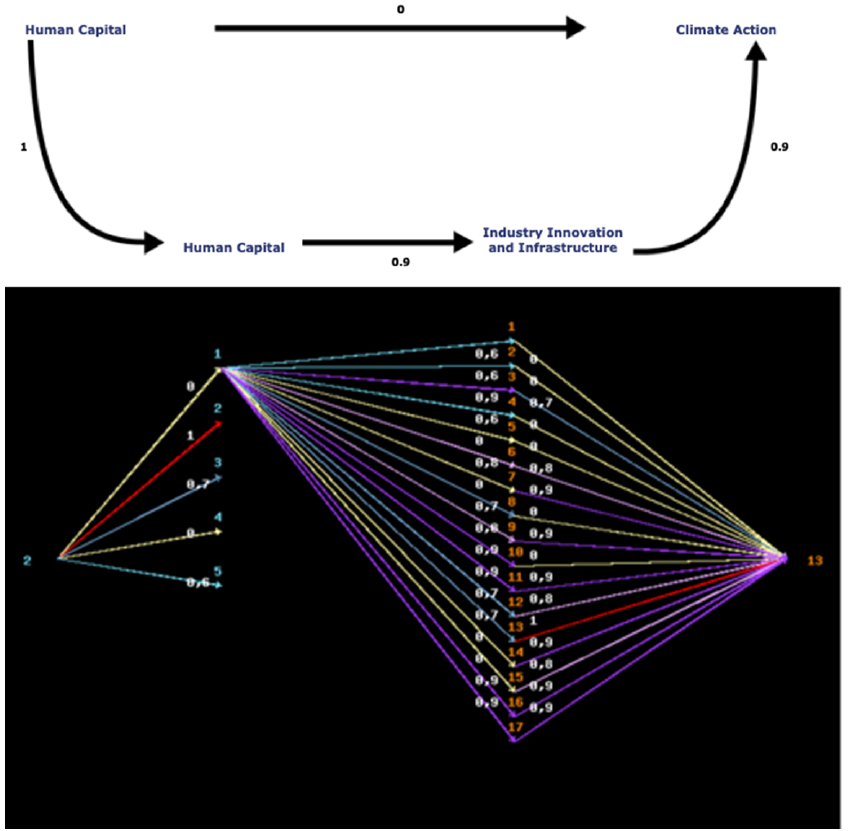
Figure 11. Relation between Human Capital (H2) and Climate Action (SDG 13).